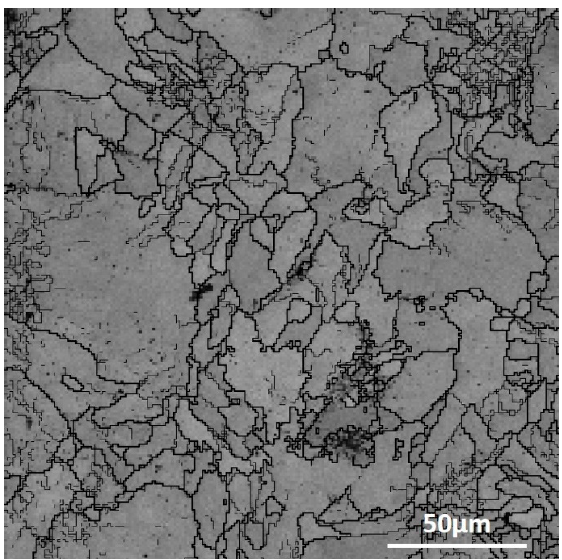
Figure 4. The high-angle grain boundaries were analyzed by electron backscattered diffraction (EBSD).